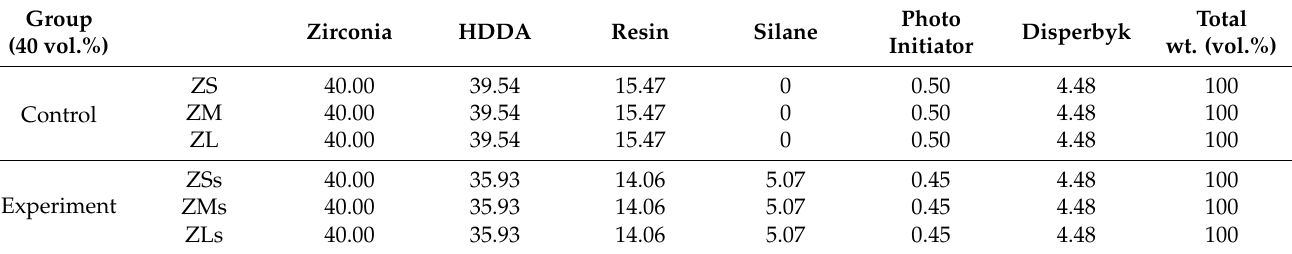
Table 2. Experimental groups used in this study (vol.%).